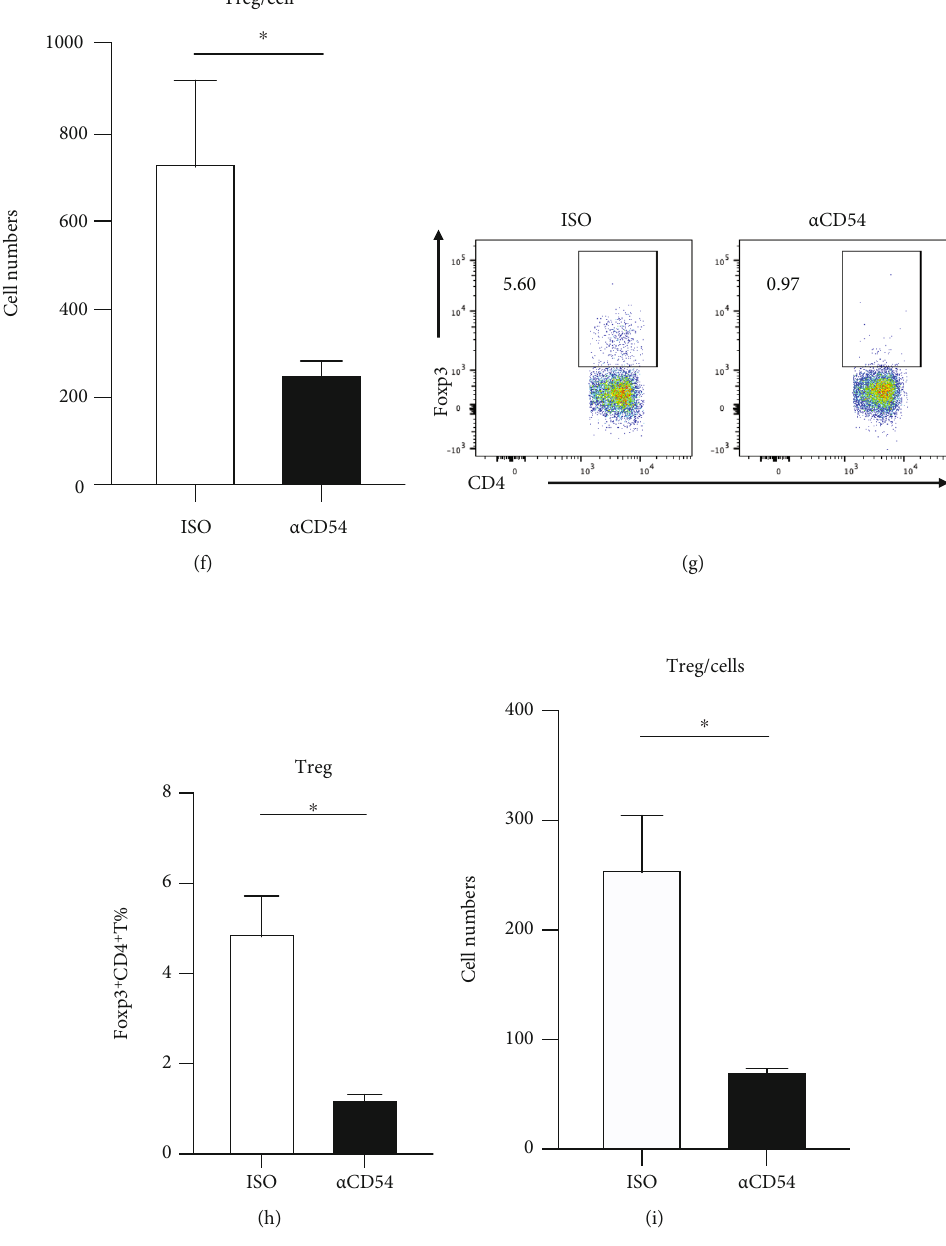
Figure 7: ICAM-1 blockade leads to the decrease in Treg in the coculture of CD4 + T cells and B cells. CD4 + T cells and B cells were sorted from PBS and pristane-treated BALB/c mouse (6 months later) by MACS, respectively. 3 × 10 4 CD4 + T cells originated from PBS or pristane-treated mice were cultured with 9 × 10 4 B cells derived from PBS mice (on a BALB/c background). After coculturing for 8 days, Foxp3 + CD4 + Treg cells were determined by fl ow cytometer in the coculture of CD4 + T cells and B cells from the PBS group (a – c) and that from the pristane-treated group (d – f). (g – i) The proportions and numbers of Treg in activated CD4 + T-B coculture upon ICAM-1 blockade were determined by fl ow cytometer. ∗ p < 0 : 05 ; ∗∗ p < 0 : 01